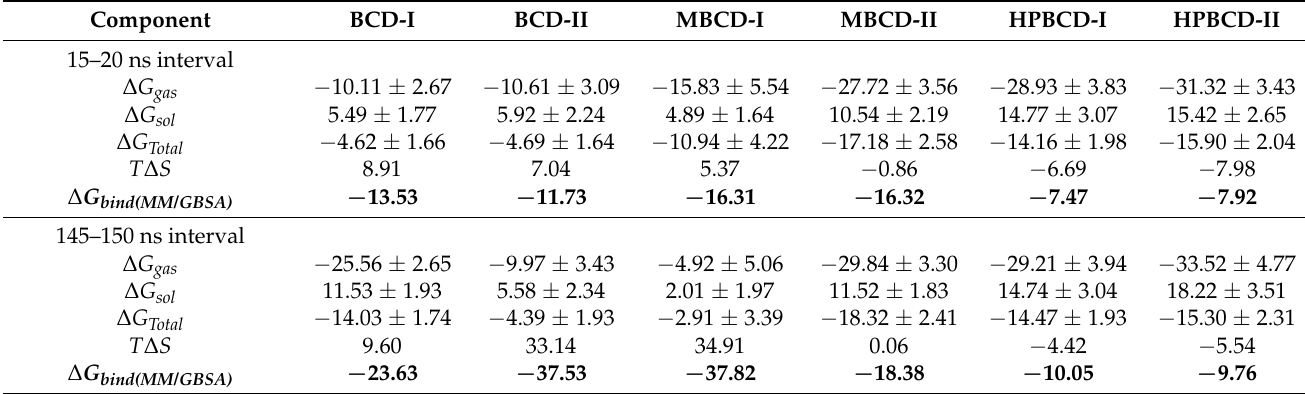
Table 1. Binding energies of all inclusion complexes, presented with major energetic components in kcal/mol from MM/GBSA calculation during two stable